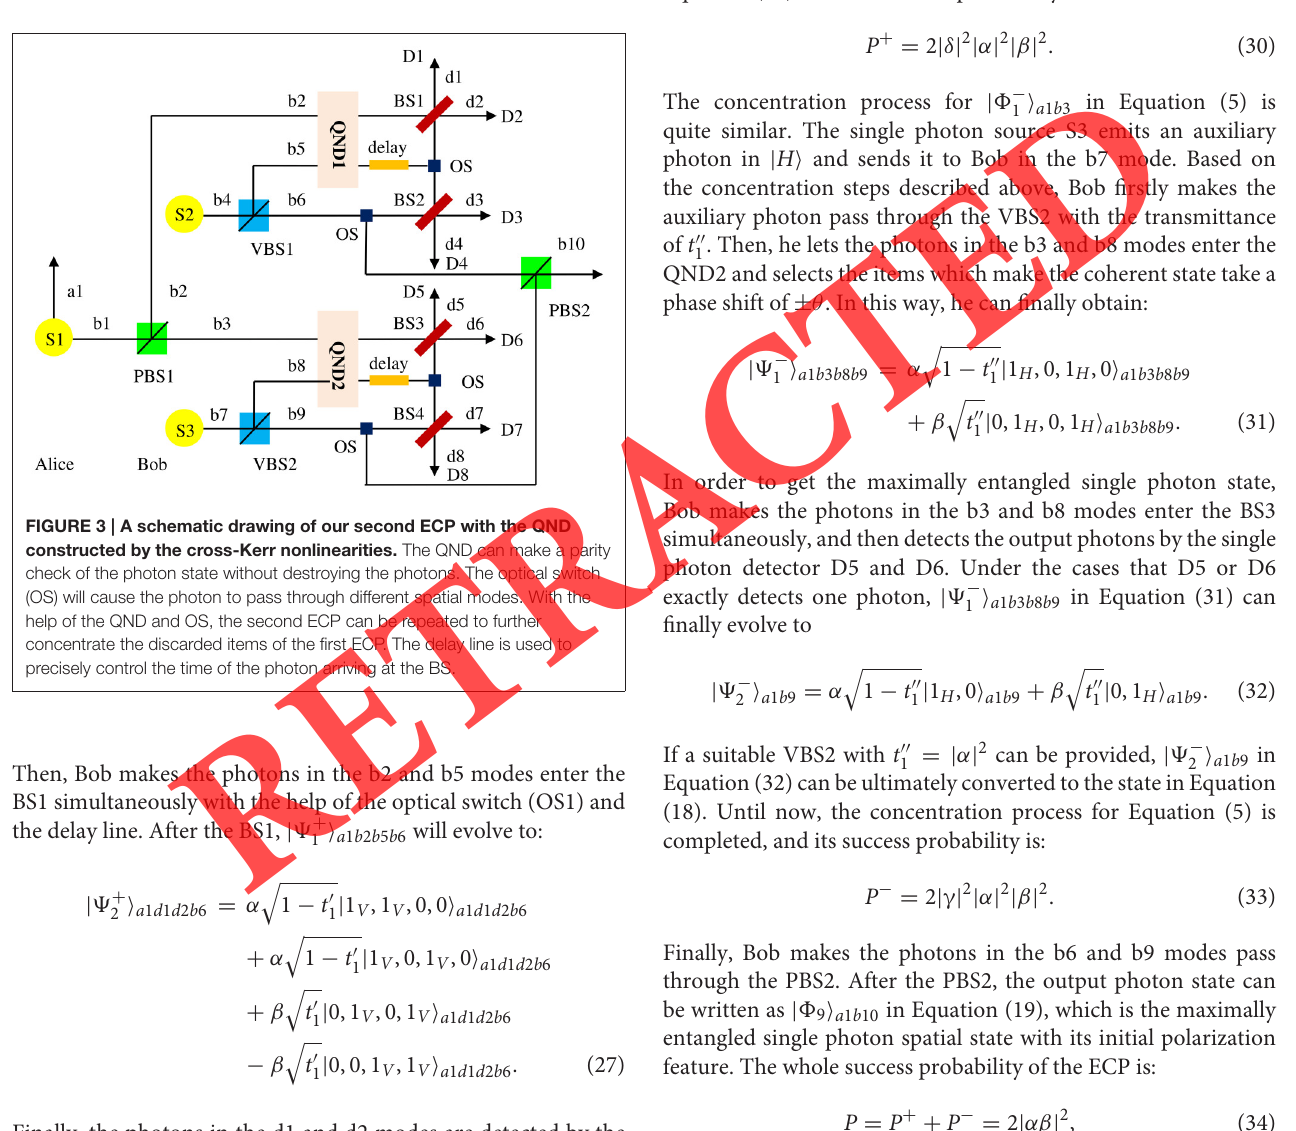
FIGURE 2 | A schematic drawing of the QND constructed by two cross-Kerr nonlinearities. The single photon in the spatial mode a1 will make the coherent state pick up the phase shift of θ , while the single photon in θ . the mode a2 will make it pick up −